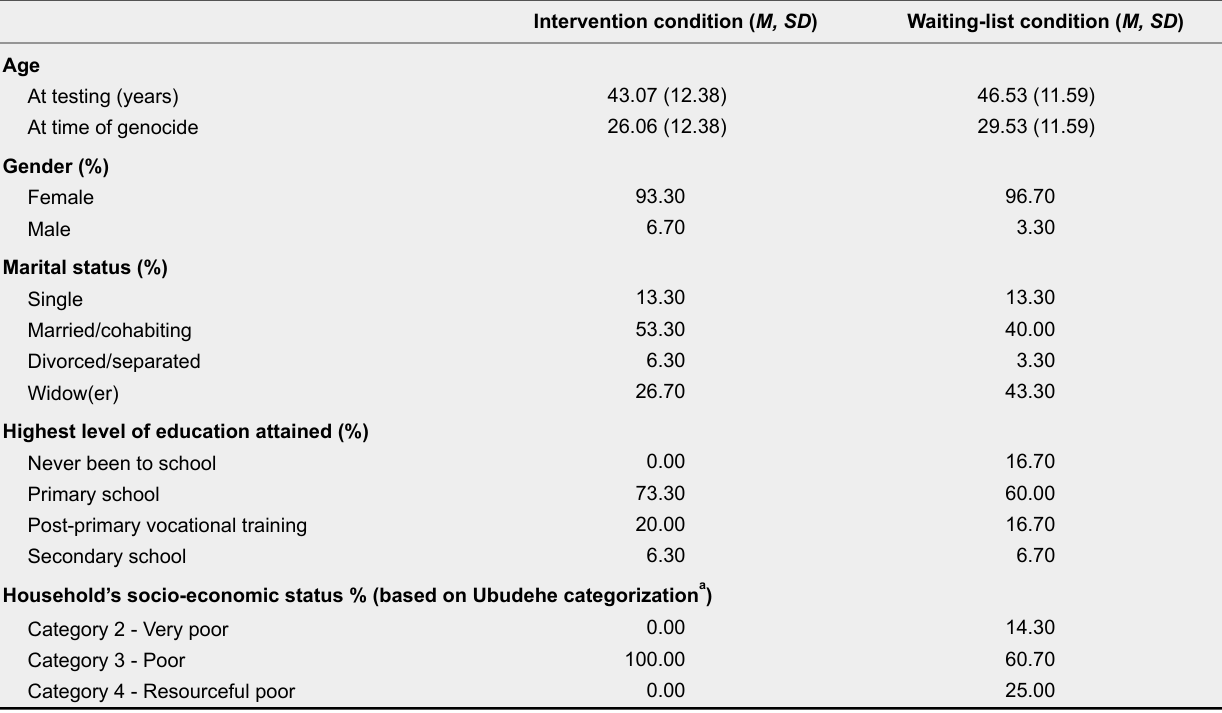
Socio-Demographic Characteristics of Intervention and Waiting-List Condition